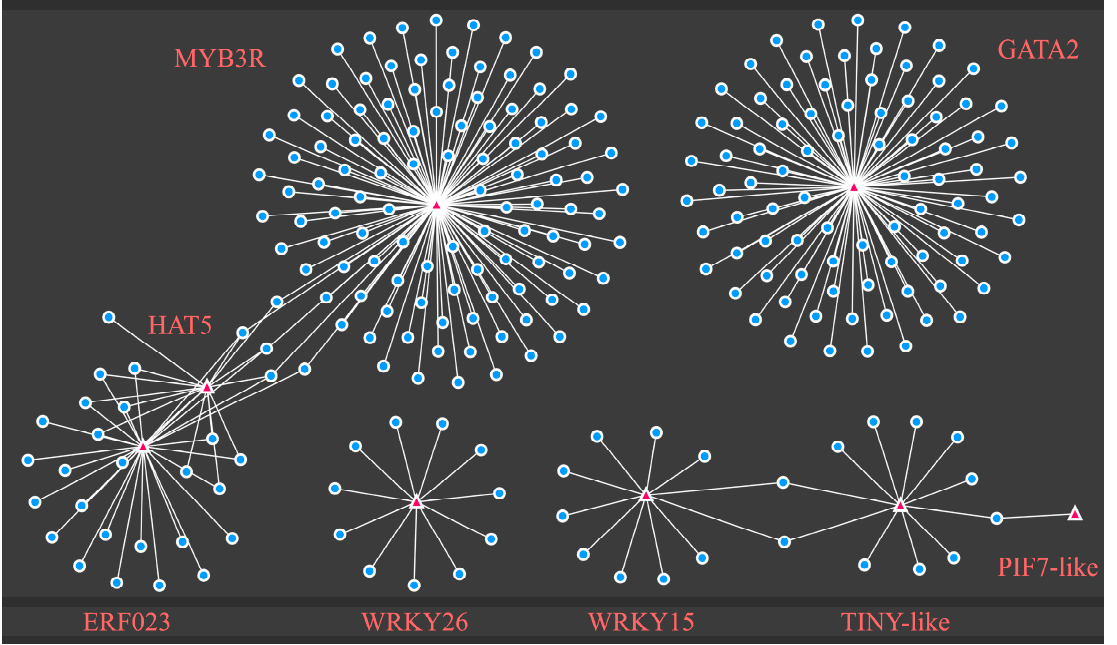
Figure 7. Visualization of the network of differentially expressed transcription factors with differential chromatin accessibility motifs. Co-expression network of differentially expressed genes connected with differential ATAC signaling motif enrichment transcription factors. Triangles represent differential ATAC signaling motif enrichment transcription factors and circles represent genes as- sociated with these transcription factors.